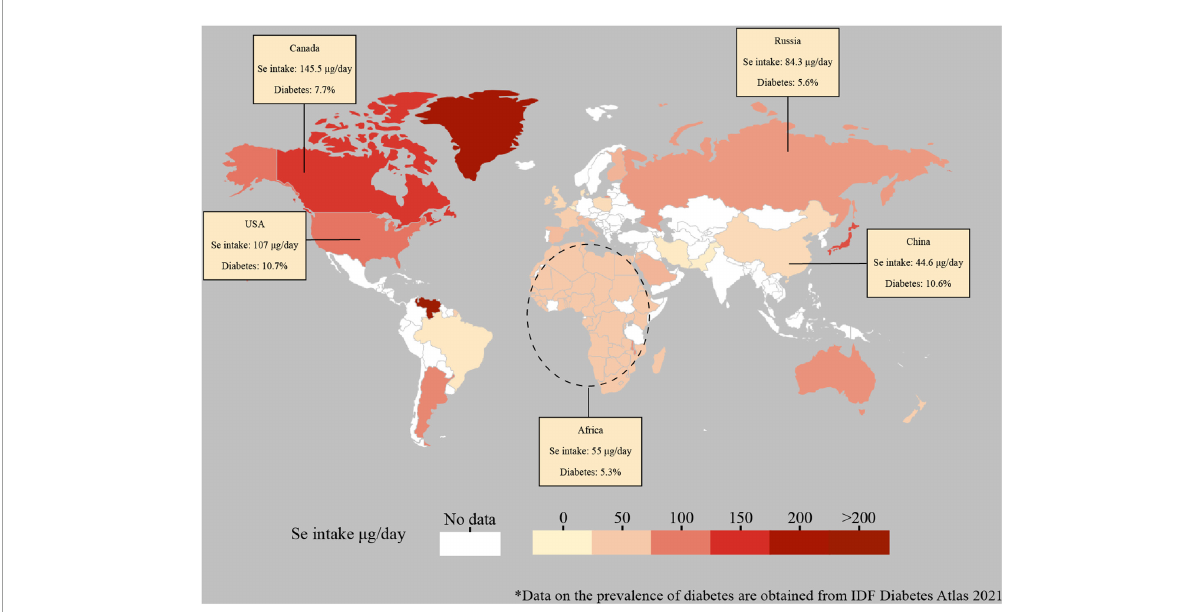
FIGURE2 Global estimated daily intake of selenium and prevalence of diabetes. Data for the global estimated daily selenium intake are adapted from the published studies (95-102). The selenium data of mainland China was selected. The selenium data of Africa was adapted from the Africa selenium daily supplied amount. Data for the prevalence of diabetes (data included until 2021) are derived from the Diabetes Atlas of the International Diabetes Federation (https://diabetesatlas.org/data/en/indicators/2/). Dashed lines are not supposed to accurately represent